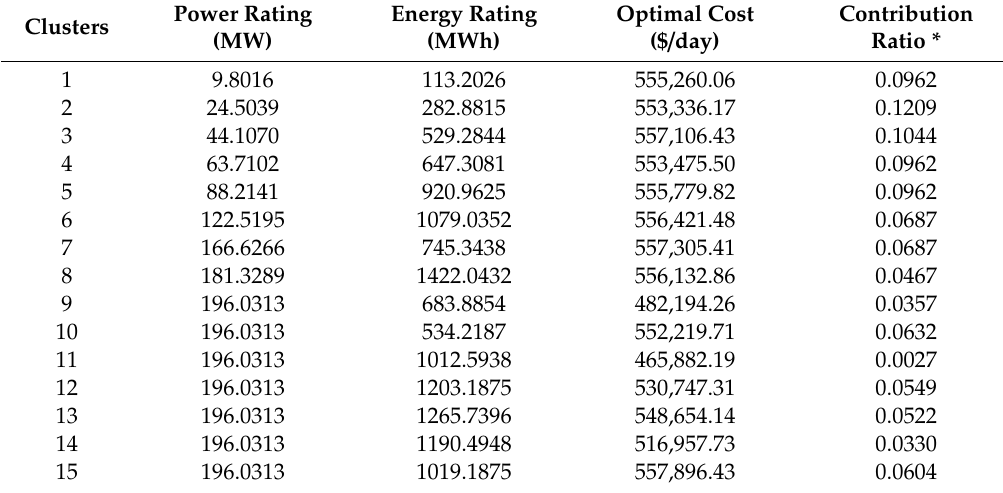
Table 1. Computation results of the representative data for case